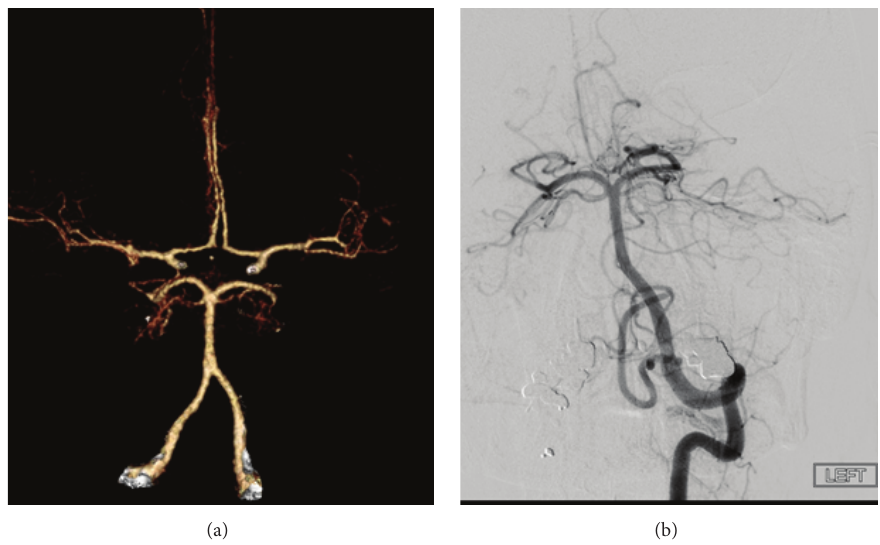
Figure 2: CT angiography (a) and a 4-vessel cerebral arteriogram (b) showed no intracranial